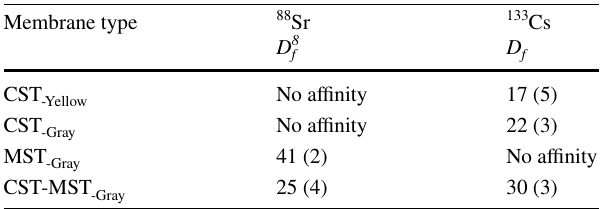
Table 13 Cellulose-based titanate support performance for 88 Sr and 133 Cs removal from deionized water media (double